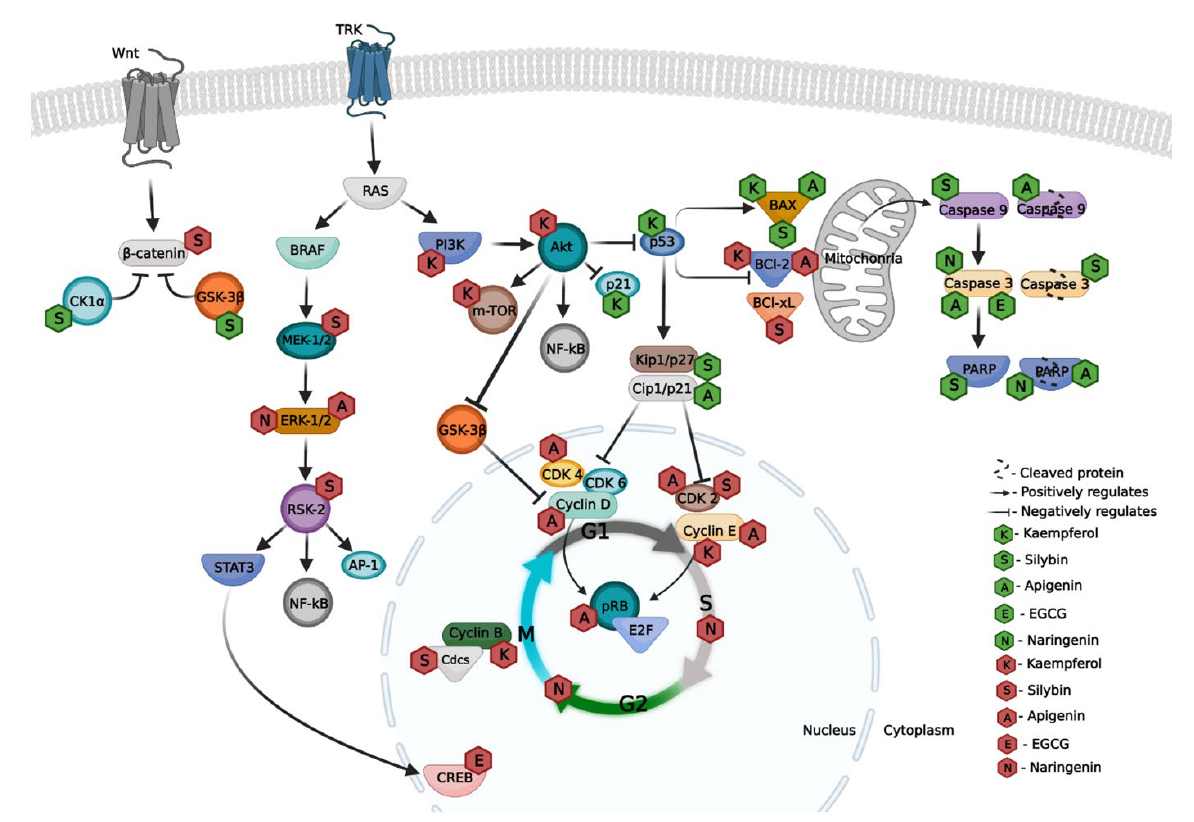
Figure 3. The Wnt and TRK signaling pathways as the main metabolic pathways mutated in melanoma and the respective site of action of the selected phenolic compounds. The inhibitory effect is denoted by red symbols and the protein activation is denoted by green symbols (see the leg- end at the right). Please see text for details. Abbreviations: K—Kaempferol; S—Silybin;